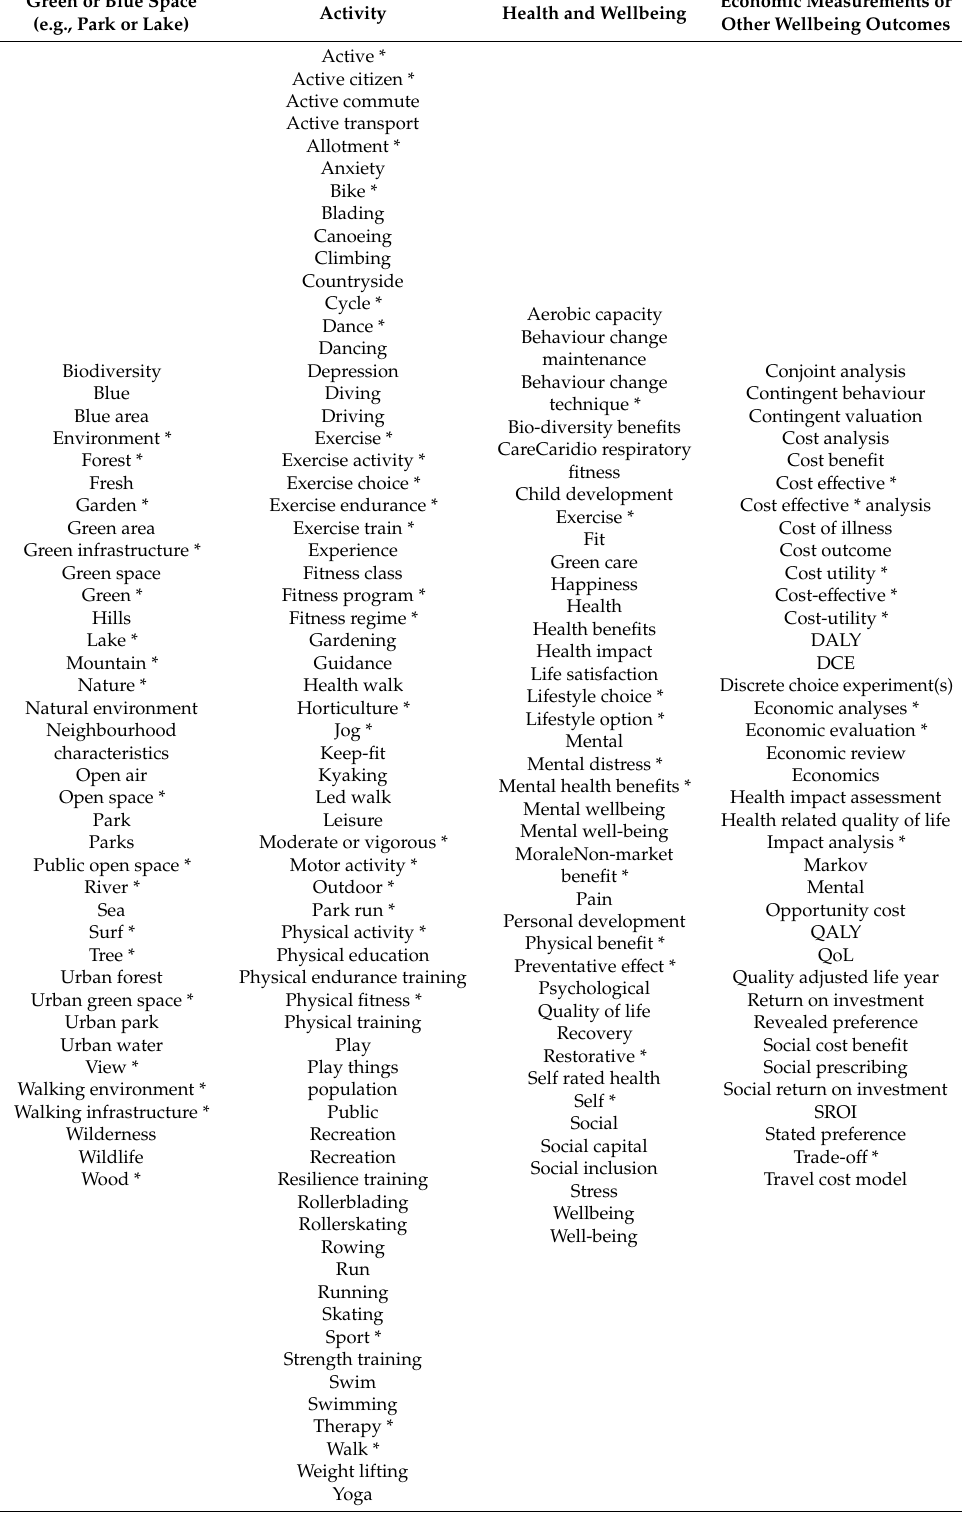
Table A2. Search terms for mixed-methods search